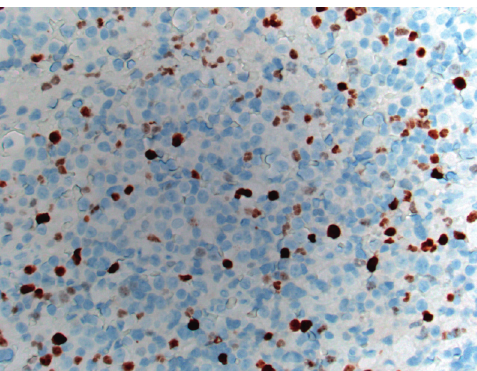
Figure 6: Immunohistochemical stain for Ki-67 showing a proliferation index of 18% by 1000 tumor cell count (400x